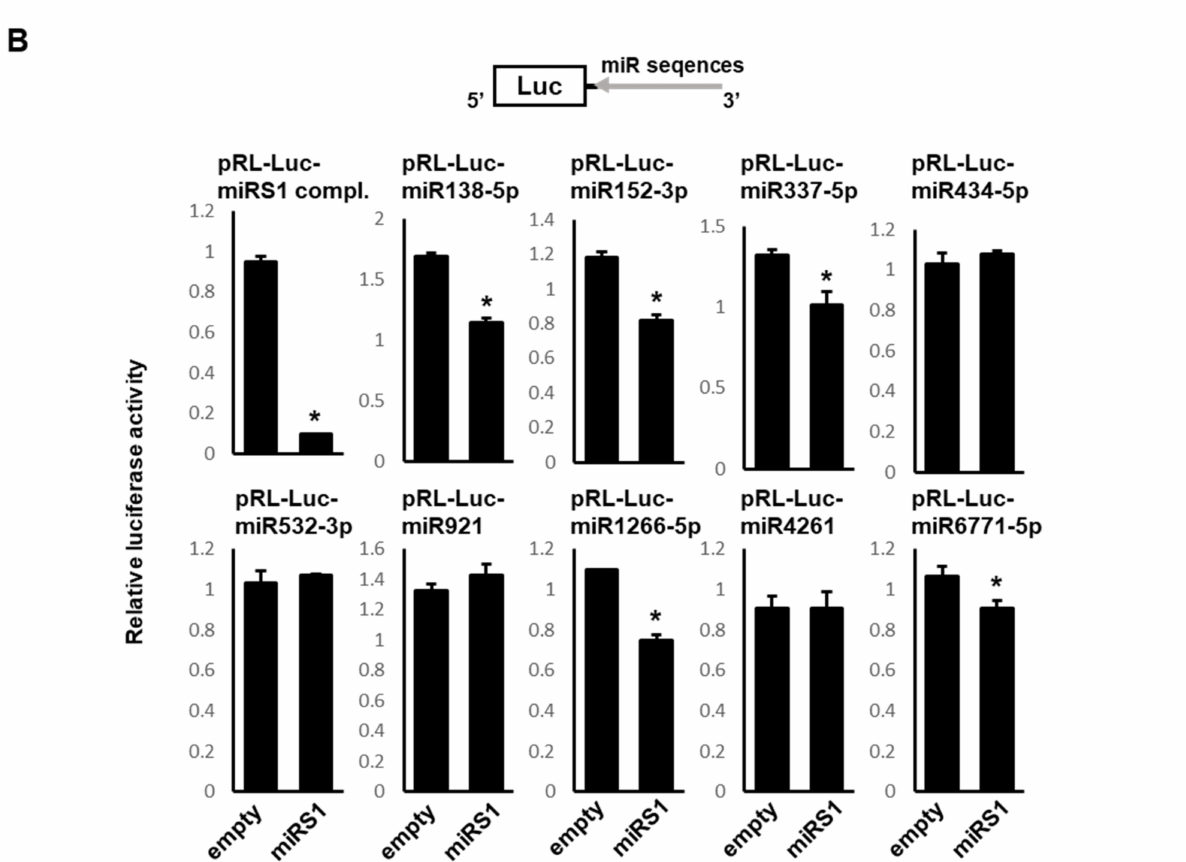
Figure 1. MiR-138-5p, miR-152-3p, miR-337-5p, miR-1266-5p, and miR-6771-5p are targets for SV40-miR-S1. ( A ) Schematic representation of possible complementary forms between miR-S1-3p and miR-138-5p, miR-152-3p, miR-337-5p, miR-434-5p, miR-532-3p, miR-921, miR-1266-5p, miR-4261, and miR-6771-5p. Seed sequences of each miRNA are underlined. ( B ) HEK293 cells were cotransfected with an internal pGL control vector, reporter vectors (pRL-Luc-miR-S1 compl., pRL-Luc-miR-138-5p, pRL-Luc-miR-152-3p, pRL-Luc-miR-337-5p, pRL-Luc-miR-434-5p, pRL-Luc-miR-532-3p, pRL-Luc- miR-921, pRL-Luc-miR-1266-5p, pRL-Luc-miR-4261, and pRL-Luc-miR-6771-5p), and mammalian expression vectors encoding pre-miR-S1 (CMV-miR-S1-PGK-puro) at a molar ratio of 1:5:25. pRL- Luc-miR-S1 compl. (described in [16]) was used as a positive control. The relative luciferase activities were calculated by dividing the value of pRL by the value of pGL. All values were normalized by empty vector-transfected cells. All experiments were repeated three times. Columns, mean values ( n = 3); bars, standard deviation (SD); * p <